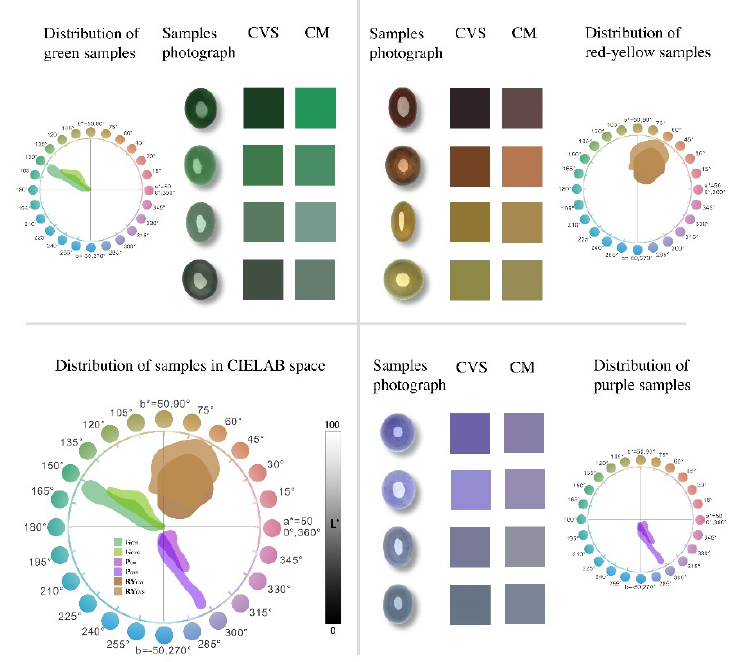
Figure 3. Colour distribution of samples in the CIELAB space for the CVS and CM tests. For the green jadeite-jade, L*, a*, and h measured by the CVS and CM differed significantly (P < 0.05), whereas b* and C* did not (P > 0.05). a* was negative, and the absolute value of a* measured by the CM was greater than that measured by the CVS, indicating that the “green” measured by the CM was stronger. The parameter b* was positive, and the absolute value of b* measured by the CVS was greater than that measured by the CM, indicating that the sample was more “yellow” according to the CVS. The parameter h measured by the CM was greater than that measured by the CVS and was offset counterclockwise in the CIELAB space. According to the colour distribution in the CIELAB space, green jadeite-jade tended to be blue for the CM and yellow for the CVS. A negative value of ∆ C* indicated that the colour saturation of green jadeite-jade for the CVS was below that of the